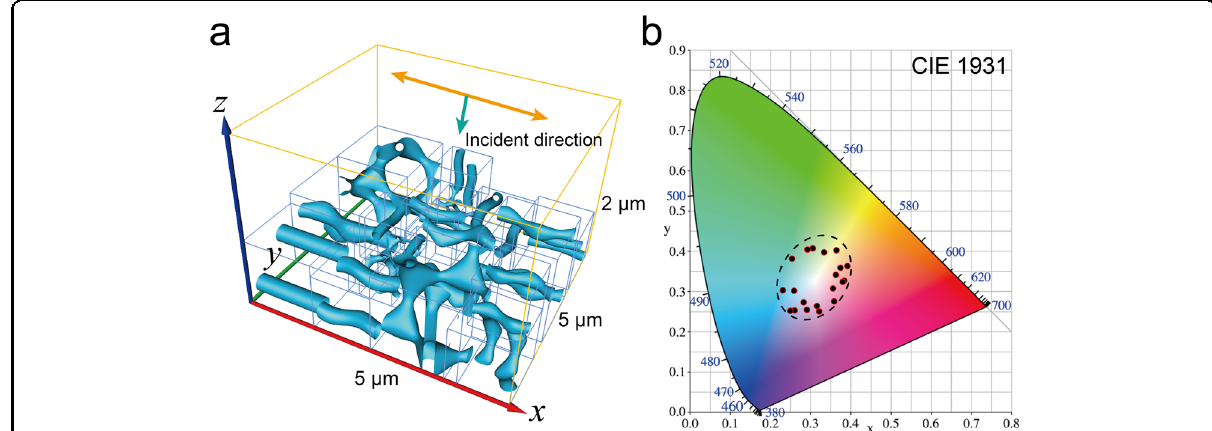
Fig. 5 Quasiordered numerical model and optical response. a Schematic diagram of the generated structural blocks and simulation region. b CIE coordinates of the colors from the simulated re fl